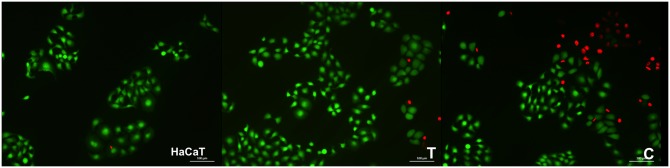
Illustrative images of HaCaT cells exposed for 24 h to GIC containing (A) or not (B) tt-farnesol analyzed by using Live/Dead assay. Green cells correspond to live cells whereas dead cells are stained in red.